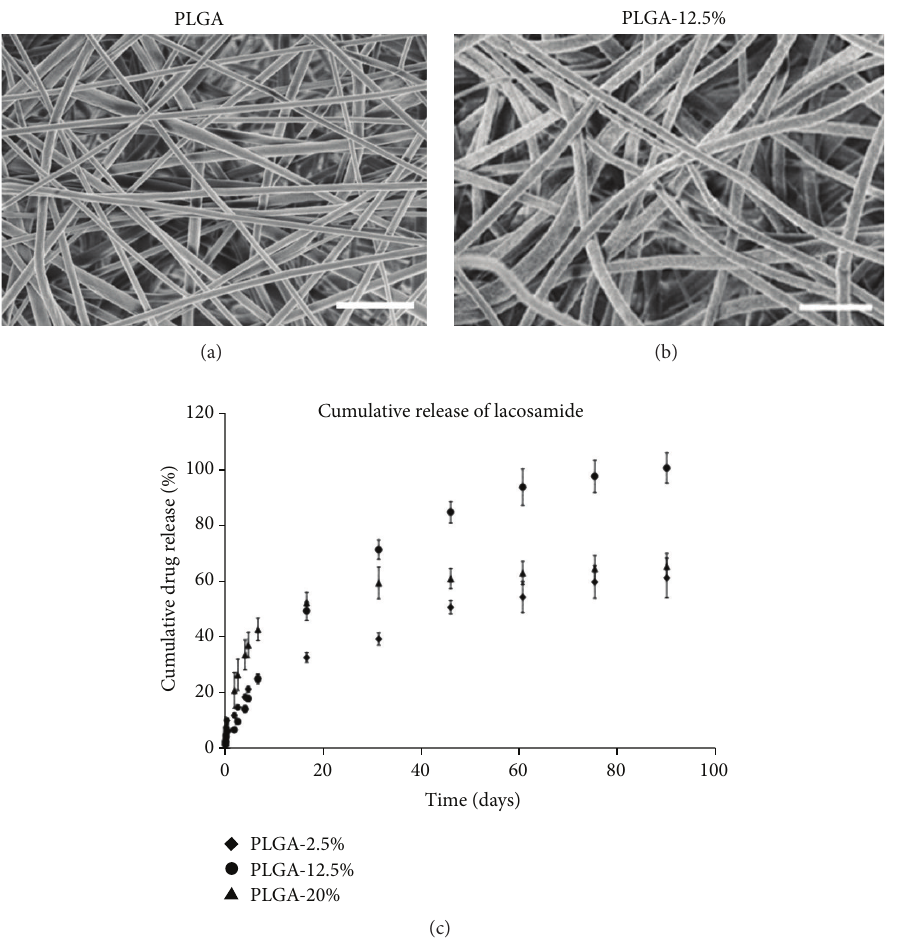
Figure 2: Scanning electron micrographs of coaxially electrospun polymer mats of PLGA Blank (a) and PLGA-12.5% lacosamide (b) (scale bar represents 10 𝜇 m). In vitro release data of lacosamide polymers with final core lacosamide concentration of 2.5, 12.5, and 20% w/w relative to the polymer (c). Bars are representing standard deviation.